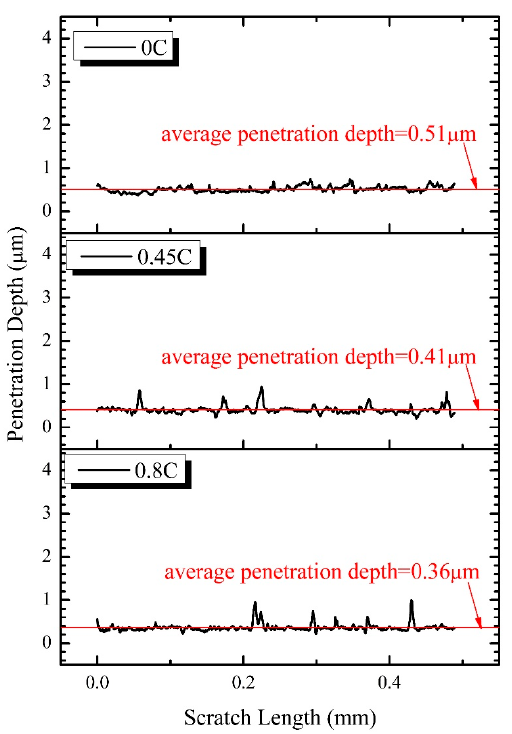
Figure 9. Variation of penetration depth with scratch length.